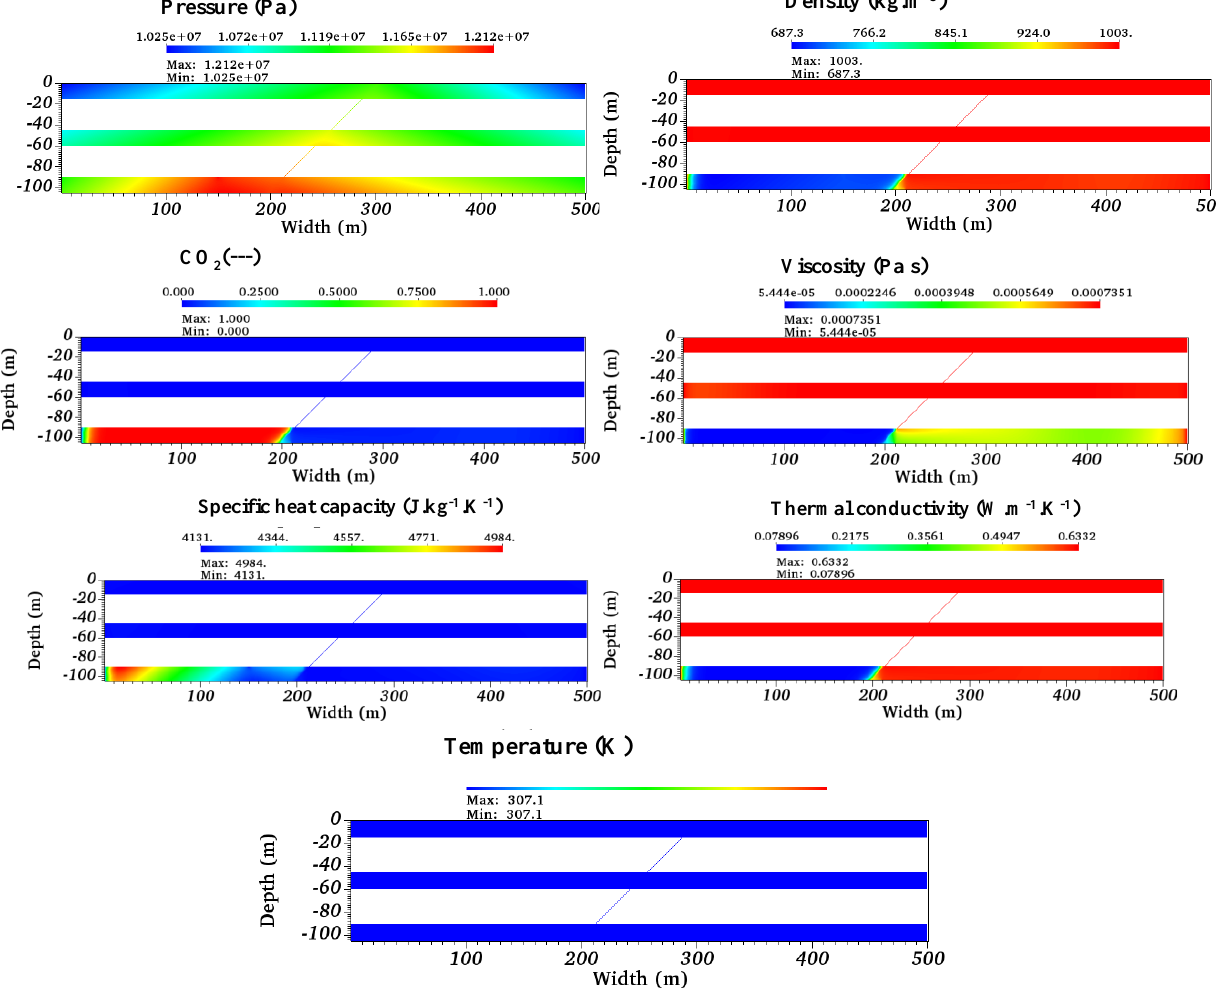
Figure 10. Distribution of pressure, density, CO 2 , viscosity, specific heat capacity, thermal conductivity, and temperature after 300 days of injection for the case with the isothermal condition, injection rate = 0.41319 m 3 /s, 𝛼 𝑙 = 5 and 𝛼 𝑡 = 0.5 and fracture aperture = 100 µm.